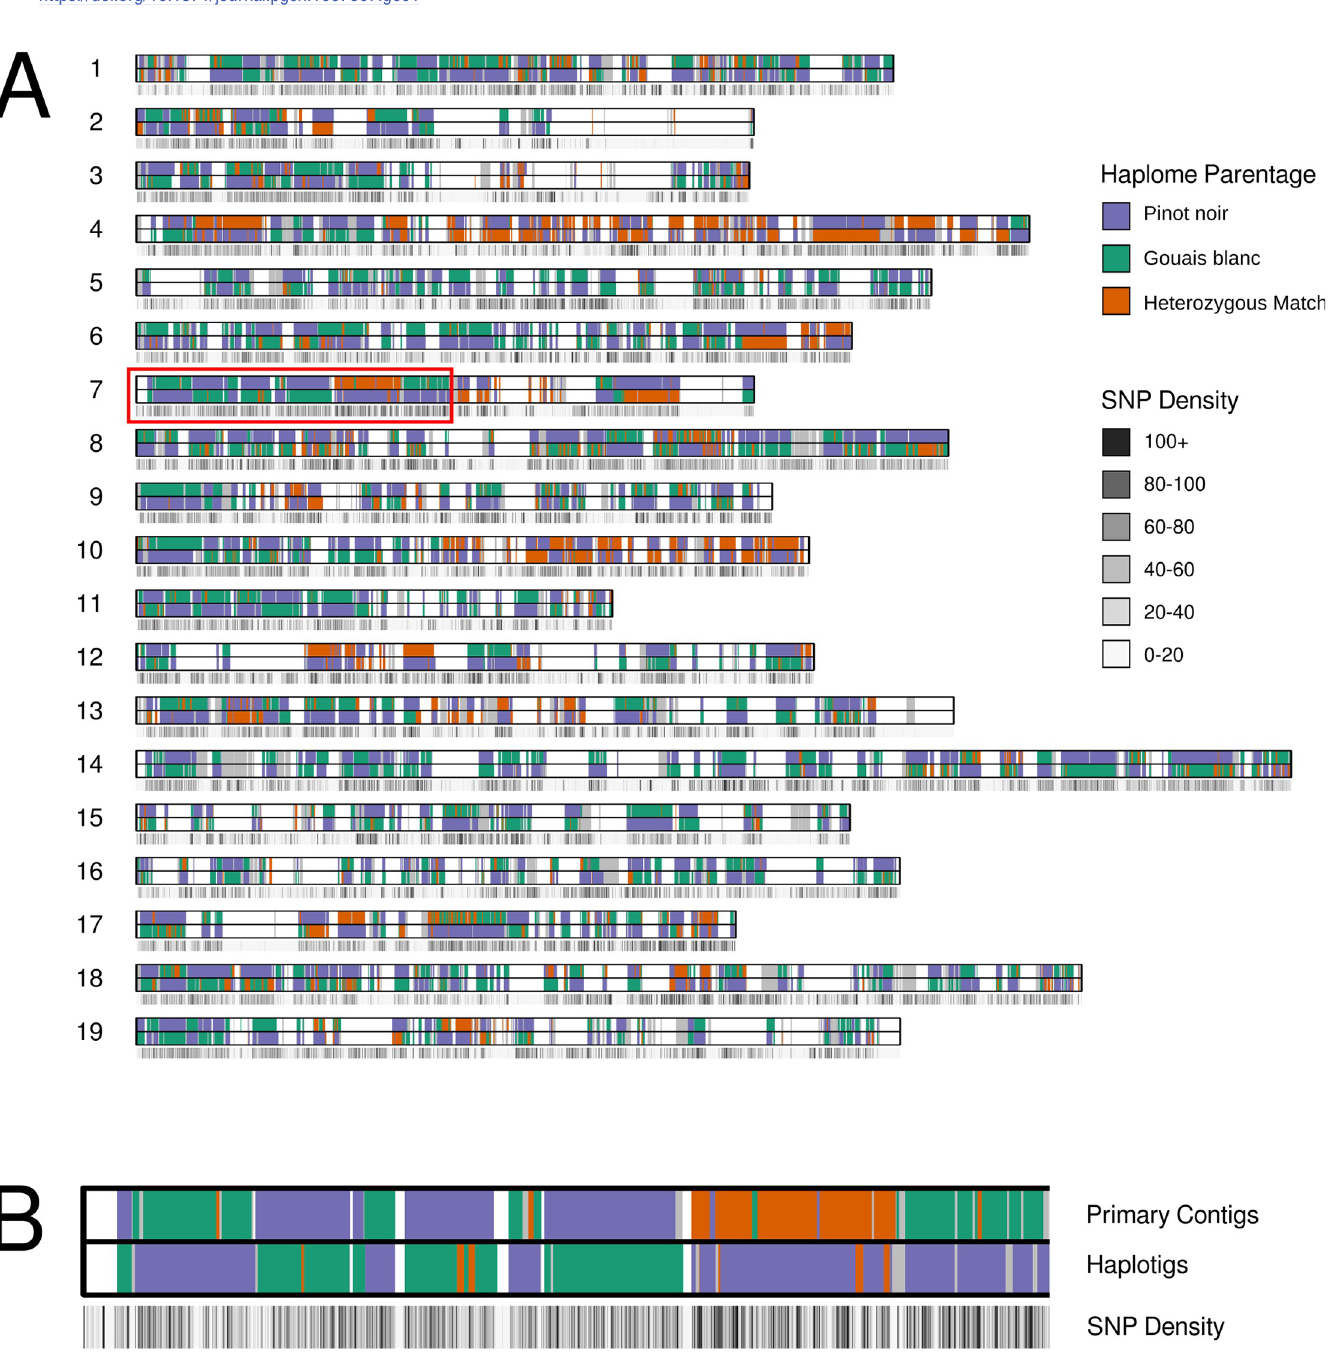
Fig 2. Parental architecture of the Chardonnay genome. (A) An ideogram of the Chardonnay reference assembly with the positions of both primary contig and haplotig phase-blocks indicated and juxtaposed with a SNP density track (for the primary contigs). Gaps in phase-blocks are indicated in white. (B) An enlargement of a region of Vitis vinifera Chromosome 7 (red box) in Fig